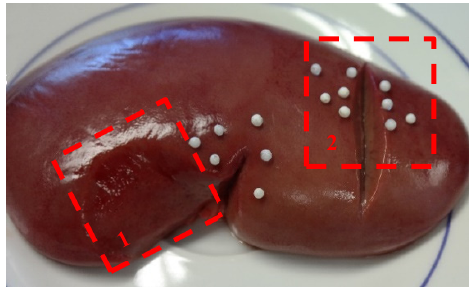
Figure 10. Specimen of a moistened pig kidney with highlighted areas of investigation for experiments.